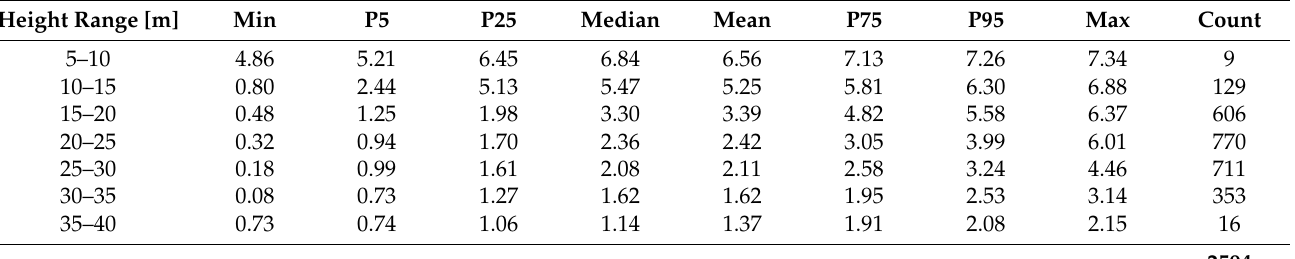
Table 1. Descriptive statistics of ten years (2007–2017) of height growth of Scots pine trees in different initial height